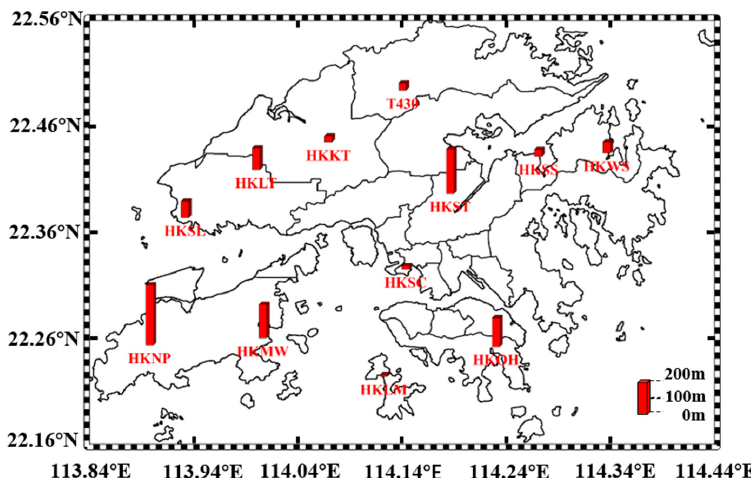
Figure 2. Geographic distribution of GNSS stations and their elevations.